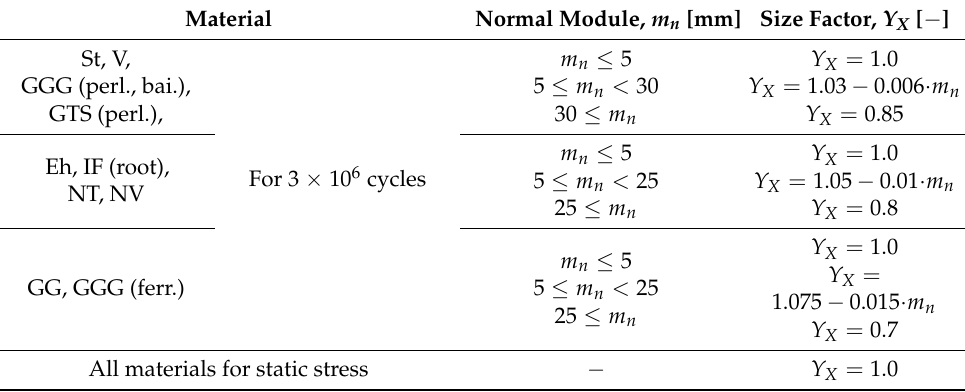
Table 1. Size factor for different modules and